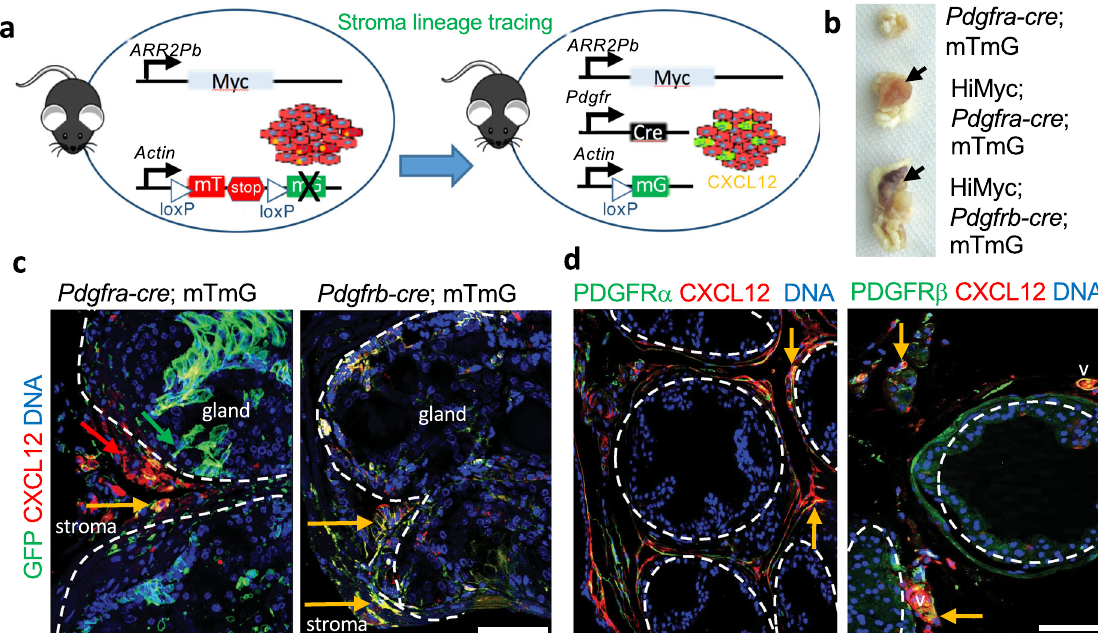
Fig. 3 CXCL12 in tumors are expressed by Pdgfr + lineage stromal cells. a scheme for mT (RFP)/mG (GFP) lineage tracing of CXCL12 expression in the stroma with PDGFRa-Cre and PDGFRb-Cre drivers in mice. b Representative genitourinary tracts from Pdgfra-cre;mTmG, HiMyc; Pdgfra-cre;mTmG, and HiMyc;Pdgfra-cre;mTmG mice (C57BL/6 background) fed chow at 12 months of age showing tumors (arrows) in HiMyc + mice. c PDGFRa-Cre;mTmG and PDGFRb-Cre;mTmG lineage tracing in tumors from HiMyc + mice fed chow. Cells that have expressed Cre driven by a PDGFR promoter, are mG + (as detected by anti-GFP IF) due to loxP- fl anked mT excision (mT fl uorescence in other cells is lost in paraf fi n sections). Yellow arrows indicate that mG + stroma expresses CXCL12. Tumor epithelium is de fi ned by dashed line. d Ventral prostate from HiMyc mice fed chow subjected to IF with indicated antibodies. Note CXCL12 deposits adjacent to and co-localizing with (yellow) stromal cells expressing PDGFR α and PDGFR β . DNA is blue. Scale bar = 100